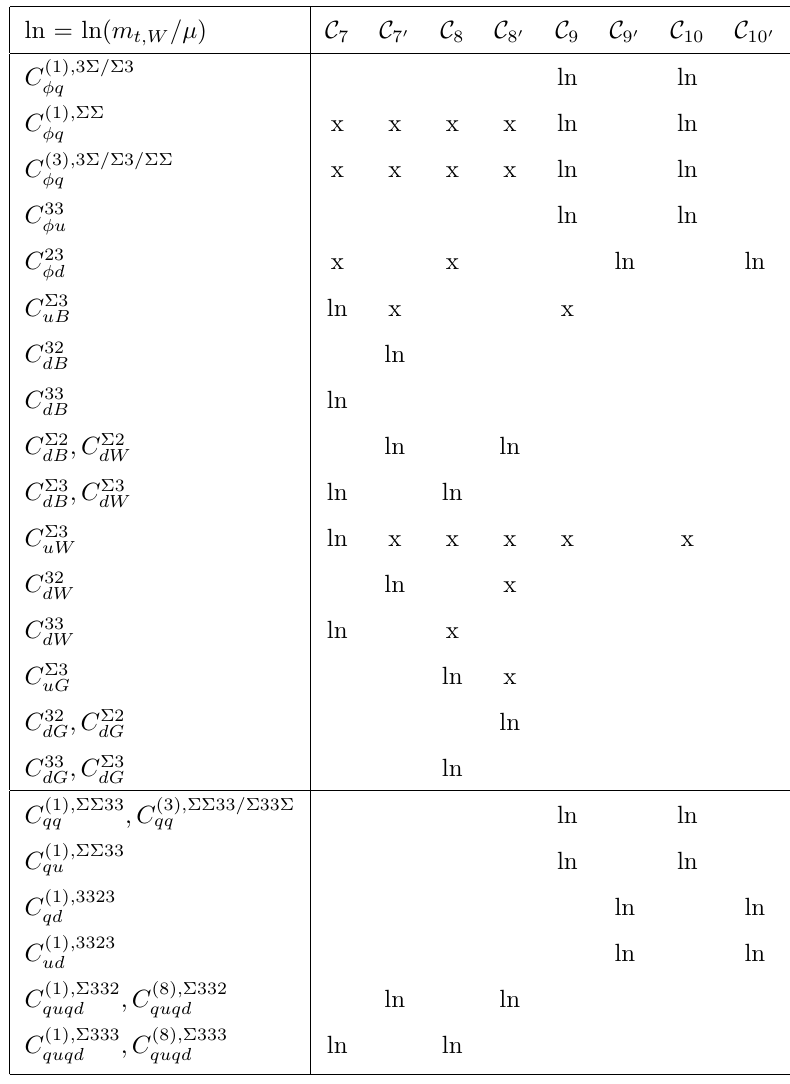
Table 11 . UV sensitivity in SMEFT-to-WET matching relations at one-loop level, resulting in a logarithmic dependence on the matching scale µ . The symbol x stands for finite matching rela- tions, ln stands for a UV-sensitive matching relation, and P denotes the sum over flavor indices k ∈ { 1 , 2 , 3 } . SMEFT coefficients with finite matching relations to all eight WET coefficients are not